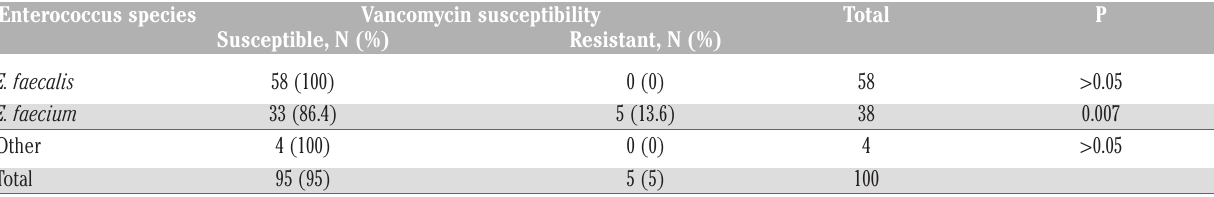
Table 4. Vancomycin susceptibility status of Enterococcus species determined by gradient difusion